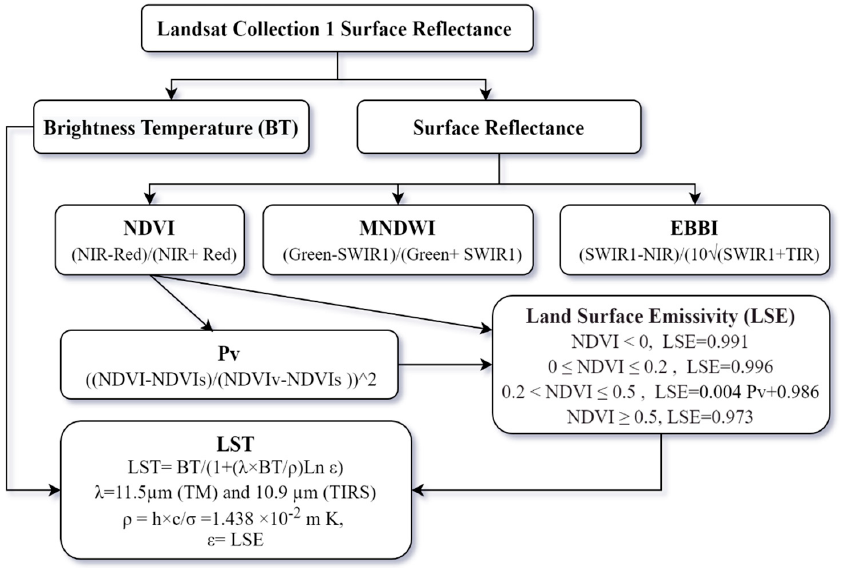
Figure 3. Calculation of the NDVI, MNDWI and EBBI and LST indices from satellite images. Nor- malized Difference Vegetation Index (NDVI), also called the standardized vegetation index, is a comprehensive reflection of vegetation type, coverage form, and growth conditions in unit pixel [79]; Modified Normalized Difference Water Index (MNDWI) uses green and SWIR bands for the enhancement of open water features. It also diminishes built-up area features that are often correlated with open water in other indices [80]; Enhanced Built-Up and Bareness Index (EBBI) is able to map built-up and bare land areas using a single calculation. The EBBI is the first built-up and bare land index that applies near infrared (NIR), short wave infrared (SWIR), and thermal infrared (TIR) channels simultaneously [81]; Proportional Vegetation (PV) gives the estimation of area under each land cover type. The vegetation and bare soil proportions are acquired from the NDVI of pure pixels [82]; Land Surface Emissivity (LSE) is an essential parameter for retrieving LST. The LSE indicates the actual ability of an object to emit energy relative to a black object with the same temperature [83]. Based on the reflectance characteristics and the NDVI, MNDWI, EBBI as well as the LST indices, the satellite images of the study area were finally classified (Figure 4). In this